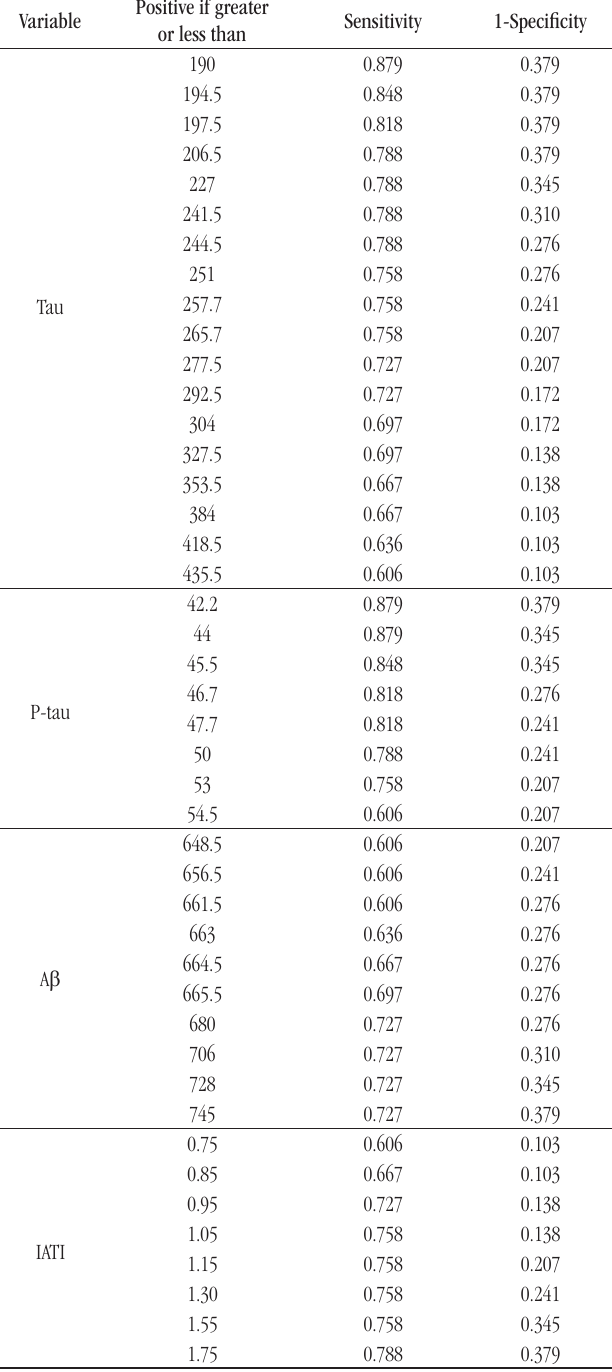
taBLE 3 − Coordinates of each ROC curves in the diagnosis of probable AD for Tau, P-tau and A β variables and IATI in the group with clinical